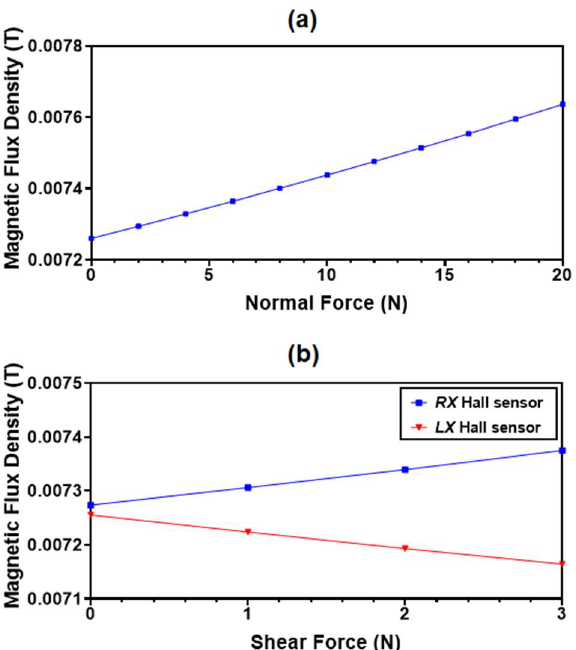
Figure 6. ( a ) Simulated average magnetic flux density value at all four Hall sensors for an applied normal force; ( b ) magnetic flux density value at RX and LX Hall sensors for applied shear force in normal force; ( b ) magnetic flux density value at (cid:1844)(cid:1850) and (cid:1838)(cid:1850) Hall sensors for applied shear force in the +(cid:1876) direction. the + x direction.